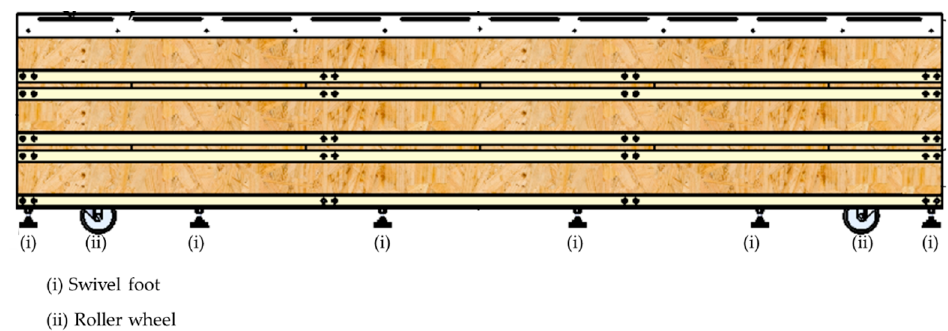
Figure 5. Side view of the wooden platform .